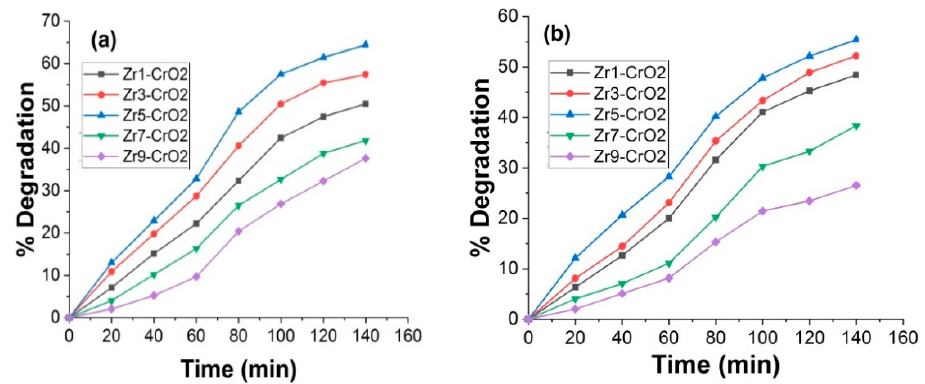
Figure 10. ( a ) Methylene blue ( b ) Methyl orange percent photocatalytic degradation.